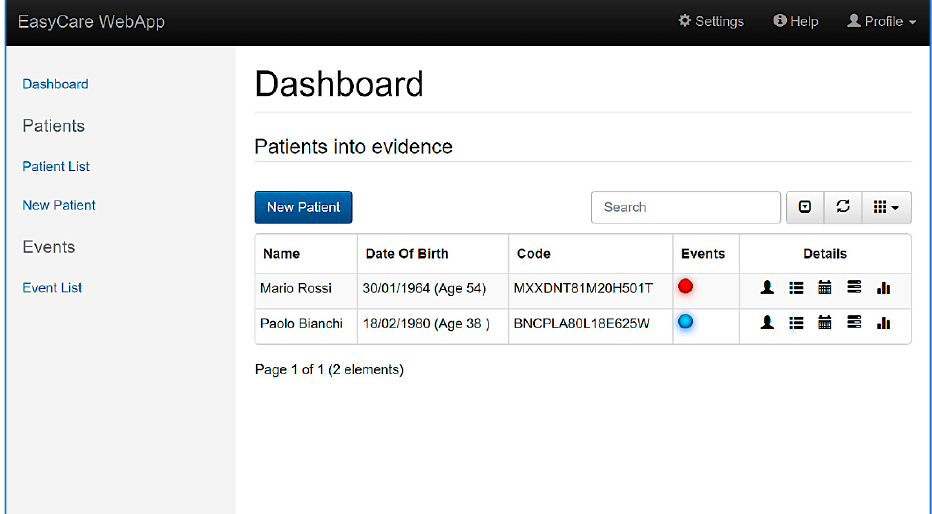
Figure 6. Dashboard page for clinicians.